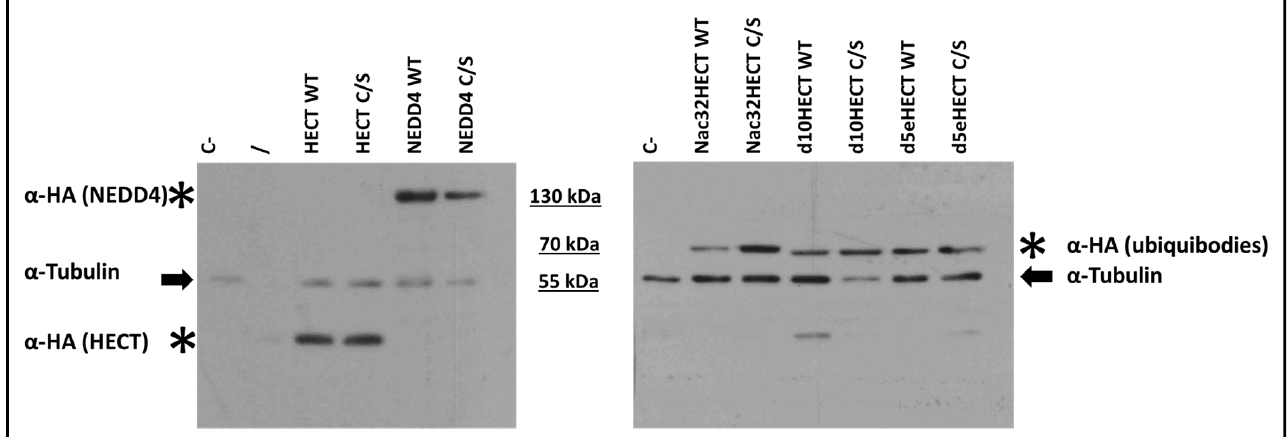
Figure 2. The developed LVs efficiently express ubiquibodies and their controls. All generated LVs (2.5 µ g) were transfected in 293T cells. Forty-eight hours post-transfection, a western blot with an HA-specific antibody, recognizing the different ubiquibodies, along with an anti-tubulin antibody, as loading control, was performed. C- stands for untransfected cells; / indicates an empty lane; arrows and asterisks point to tubulin and ubiquibodies/NEDD4/HECT domain, respectively, and as indicated.